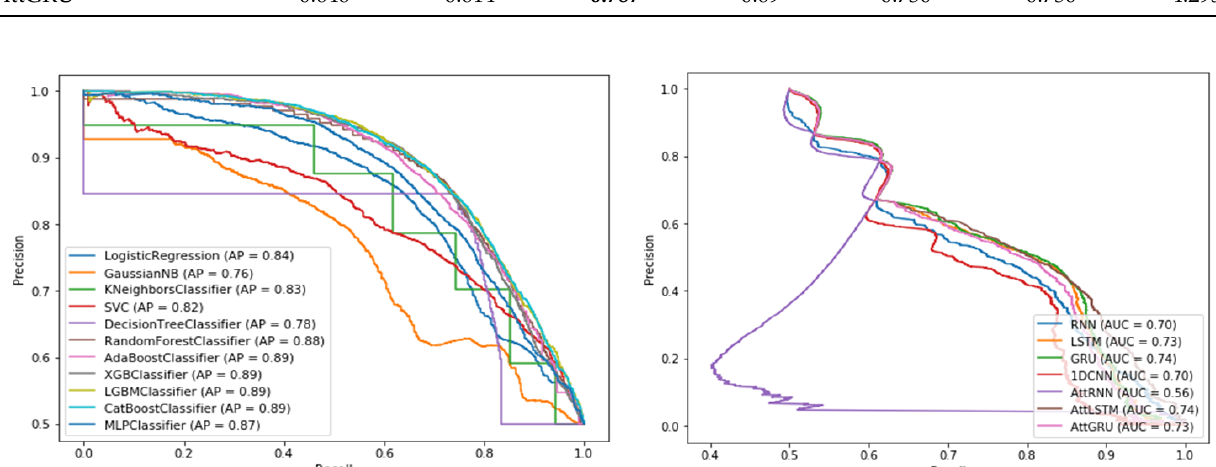
Figure 3. Comparison of the area under the receiver operating characteristic curve (AUROC) for the base model.